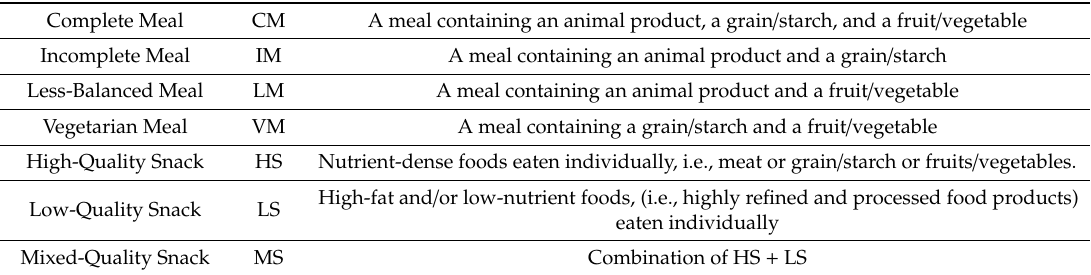
Table 1. Food-Based Classification of Eating Events (modified from Lennernas et al.